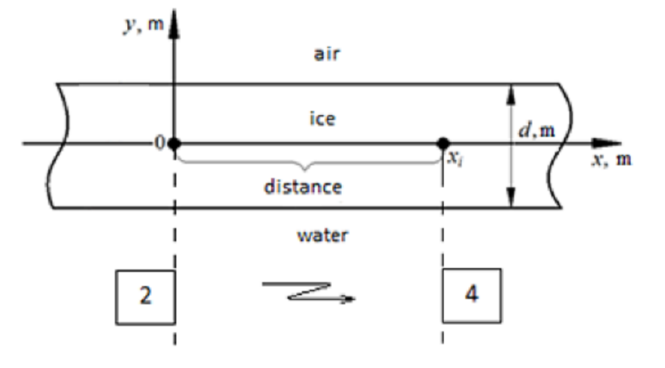
Fig.7. Scheme of radiator and receiver installation.